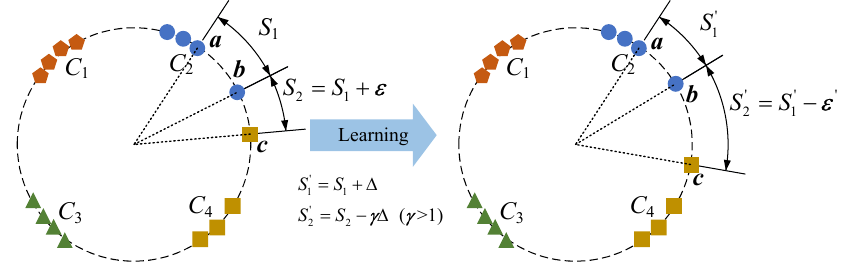
Figure 5. Learning process of the weighted cluster-range